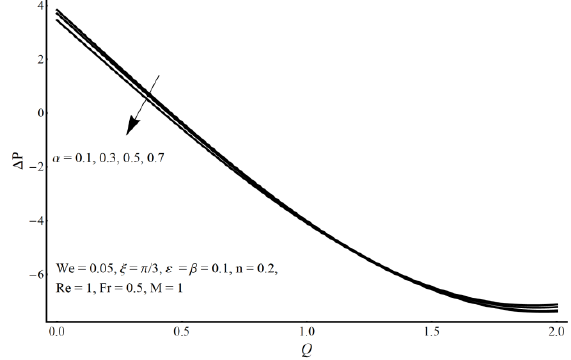
Figure 4. A 3D velocity profile when M = 1, n = α = 0.2, We 2 = 0.03, ε = β = 0.1, ξ = π/3, Fr = 0.5.